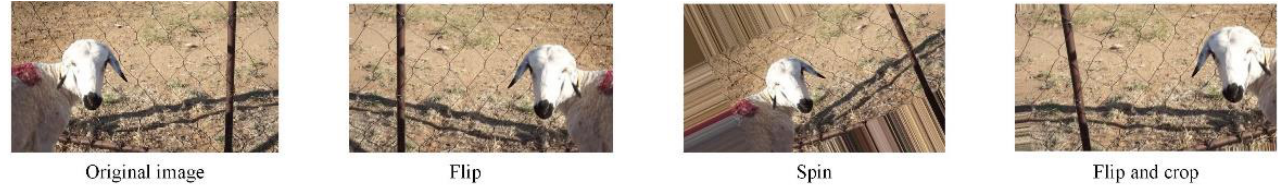
Figure 2. Data Augmentation.